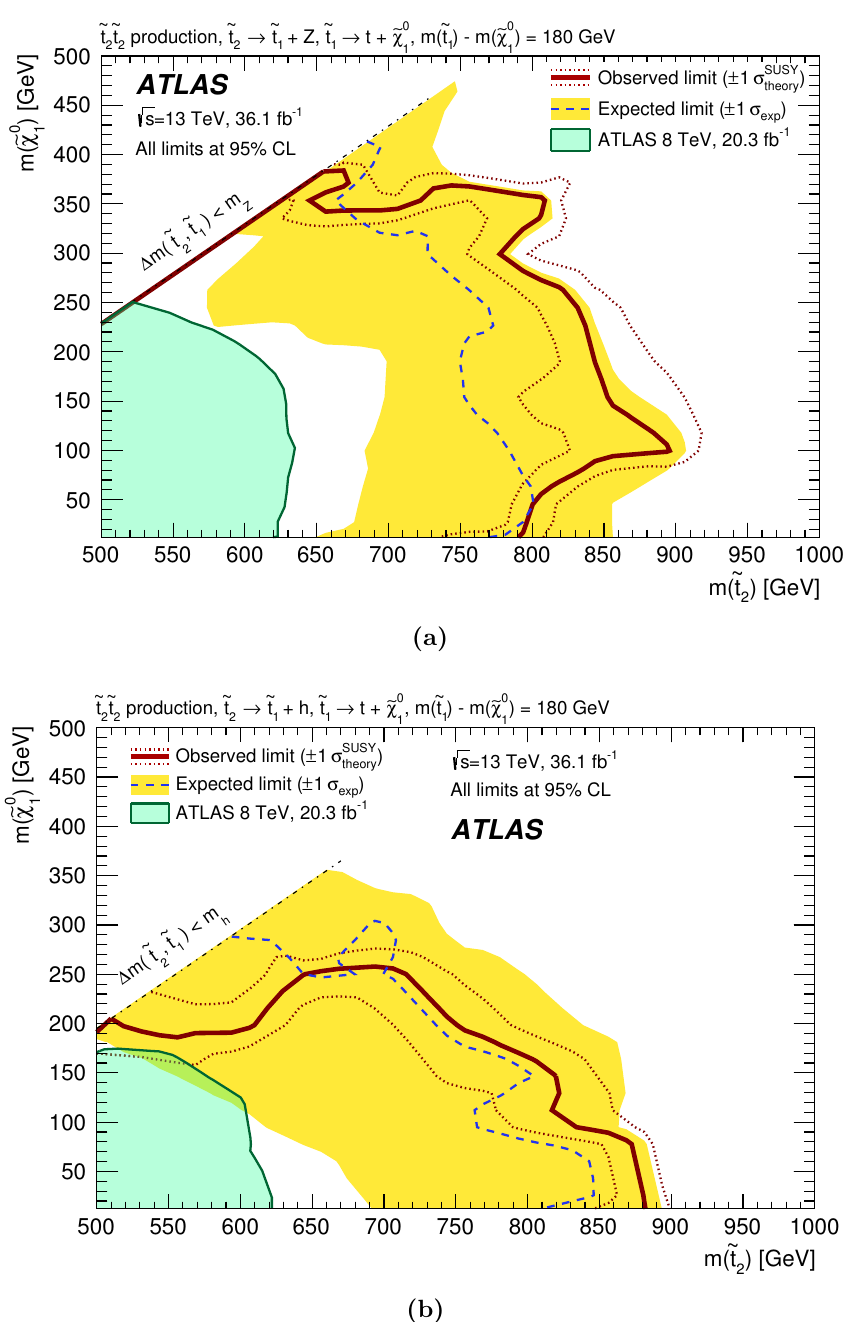
Figure 6. Exclusion limits at 95% CL from the analysis of 36 : 1 fb (cid:0) 1 of 13 TeV pp collision data on the masses of the ~ t 2 and ~ (cid:31) 0 1 , for a (cid:12)xed m ( ~ t 1 ) (cid:0) m (~ (cid:31) 0 1 ) = 180 GeV and assuming (a) B ( ~ t 2 ! Z ~ t 1 ) = 1 or (b) B (~ t 2 ! h ~ t 1 ) = 1. The dashed line and the shaded band are the expected limit and its (cid:6) 1 (cid:27) uncertainty, respectively. The thick solid line is the observed limit for the central value of the signal cross-section. The expected and observed limits do not include the e(cid:11)ect of the theoretical uncertainties in the signal cross-section. The dotted lines show the e(cid:11)ect on the observed limit when varying the signal cross-section by (cid:6) 1 (cid:27) of the theoretical uncertainty. The shaded area in p the lower-left corner shows the observed exclusion from the ATLAS s = 8 TeV analysis [19,